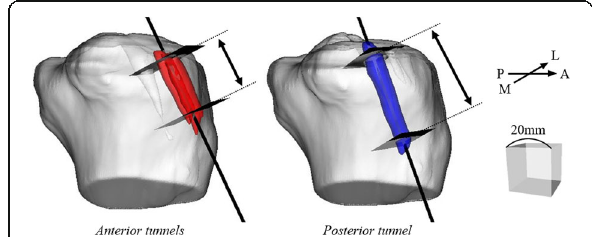
Fig. 2 Difference in the tunnel length between the anterior tunnels ( left ) and the posterior tunnel ( right ). The tunnel length was defined as the distance from the aperture plane to the most distal plane completely surrounded by bony area of the three-dimensional (3D) models of the tunnels. The red and the blue 3D models indicate the anterior and the posterior tunnels at 3 weeks after surgery. The bottom right cube has a length of 20 mm on each side. M : medial,